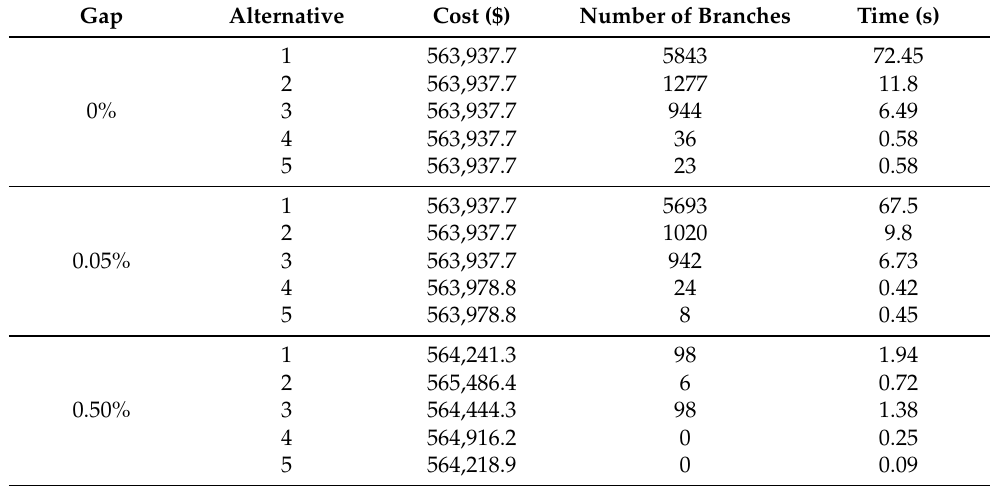
Table 8. Optimization results for 10